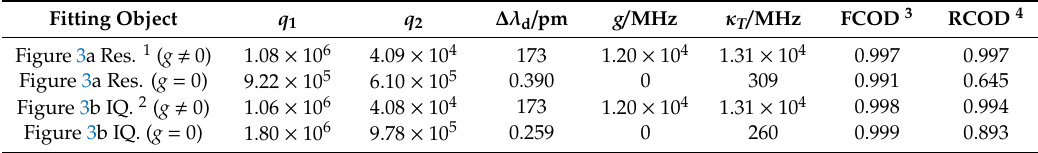
Table 2. Weakly coupled resonance fitting